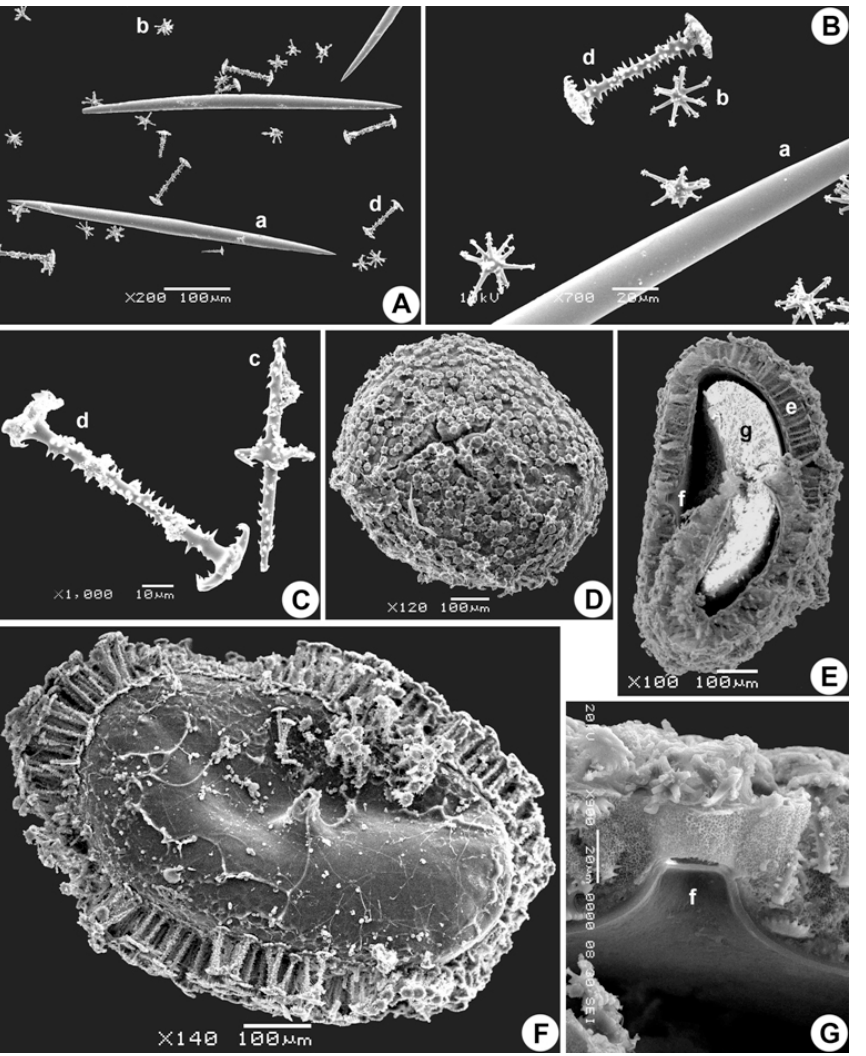
Image 4. Dosilia plumosa spicules and gemmules. A–C - megascleres, microscleres and gemmuloscleres; d - gemmule; E - cross-section of gemmule; F - gemmule with the pneumatic layer peeled off showing radial arrangement of gemmuloscleres; G - foraminal tube; a - megascleres, smooth oxeas; b - microscleres, multi-rayed euasters; c - microscleres, spined oxeas with 2–3 strong spines in the centre; d - gemmulosclere, spined birotulate; e - pneumatic layer; f - foramen & foraminal tube; g - mass of thesocytes.